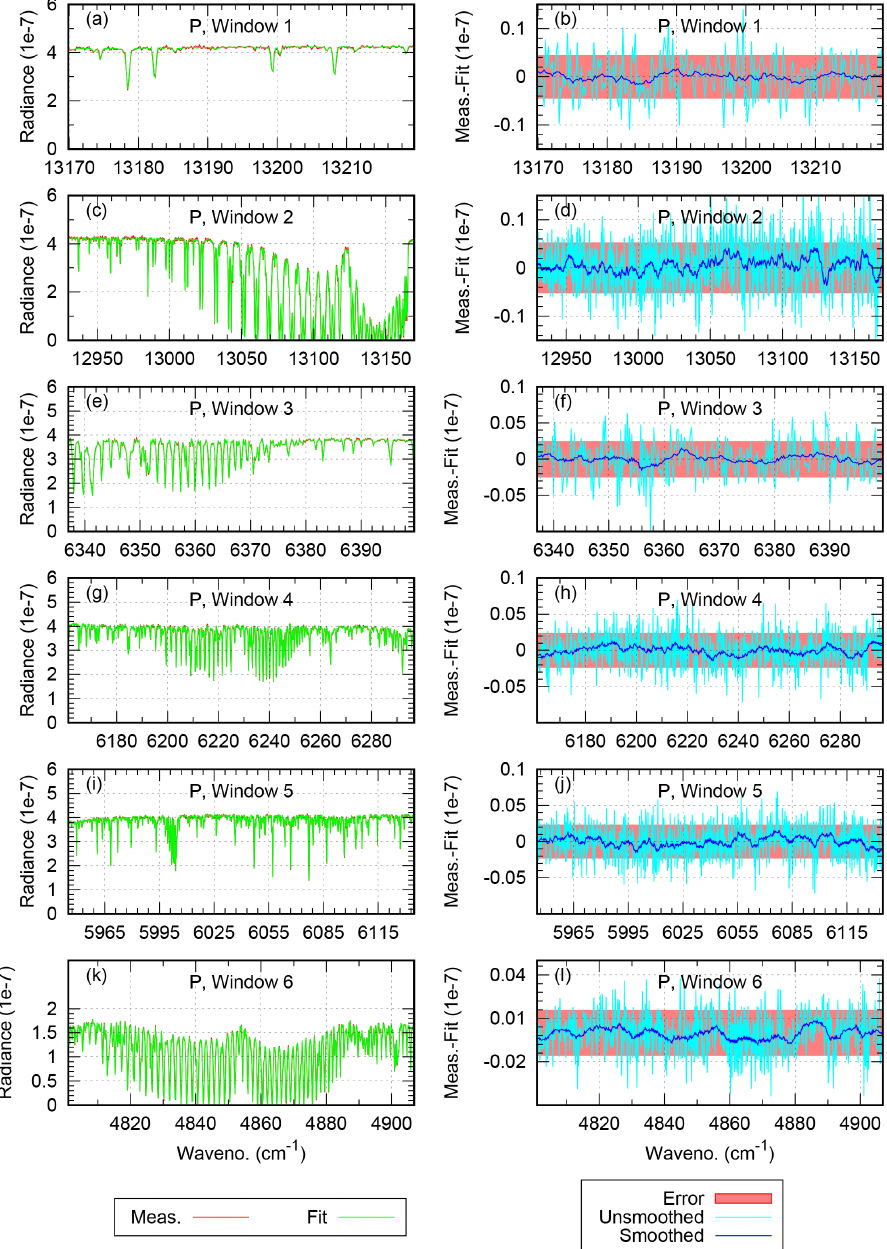
Figure 8. Example for a single GOSAT measurement (P polarisation): (a, c, e, g, i, k) measured (red) and retrieved (green) spectra in the different fit windows; because of the good agreement the red curve is essentially barely visible below the green curve. (b, d, f, h, j, l) Cor- responding residuals (measurement – fit). Light blue: unsmoothed. Blue: smoothed with a boxcar width of 21 spectral pixels ( = 4 . 2cm − 1 ). Red: estimated noise error range. The radiance unit is Wcm − 2 cmsr − 1